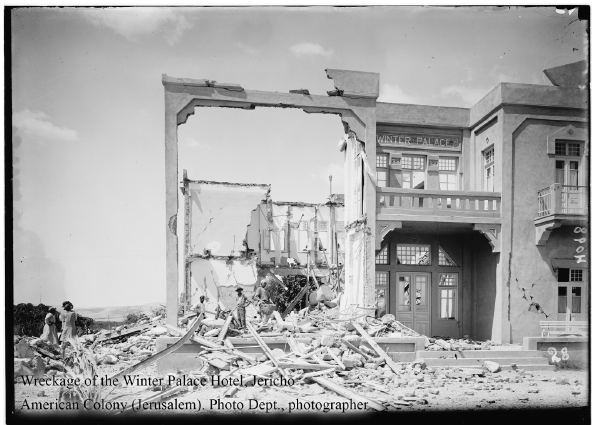
Figure 3. Wreckage of the Winter Palace Hotel, Jericho, after the 1927 earthquake. American Colony (Jerusalem). Photo Dept., pho-